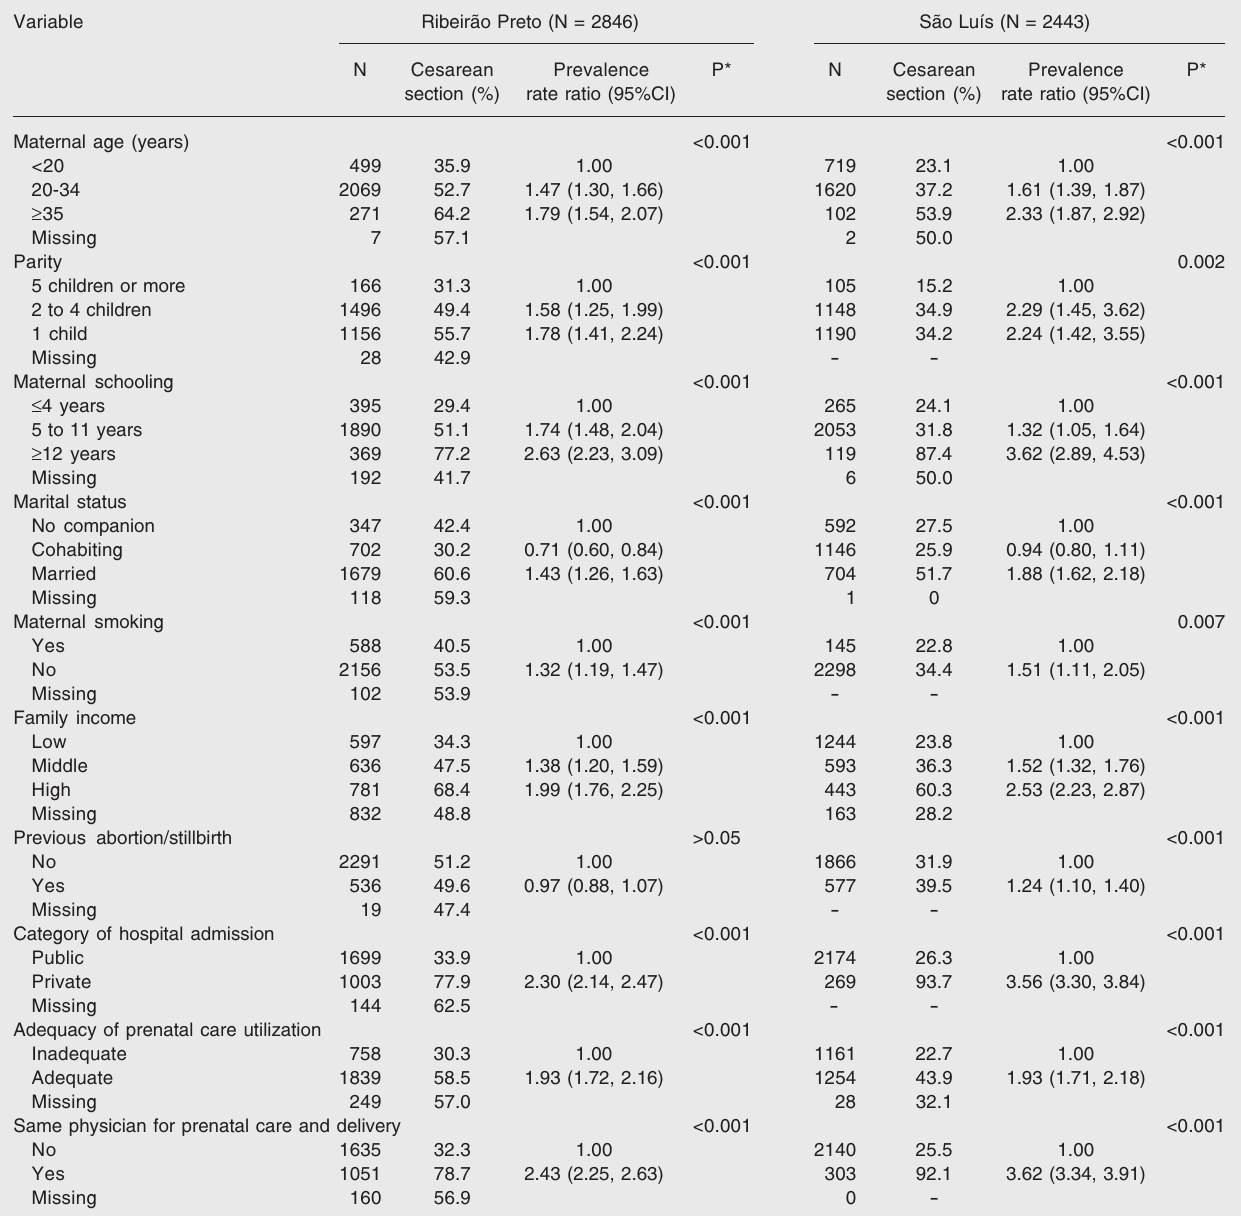
Table 1. Non-adjusted analysis of risk factors for cesarean section (Ribeirão Preto, 1994 and São Luís, 1997/1998). Variable Ribeirão Preto (N = 2846) São Luís (N = 2443) N Cesarean Prevalence P* N Cesarean Prevalence P* section (%) rate ratio (95%CI) section (%) rate ratio (95%CI) Maternal age (years) <0.001 <0.001 <20